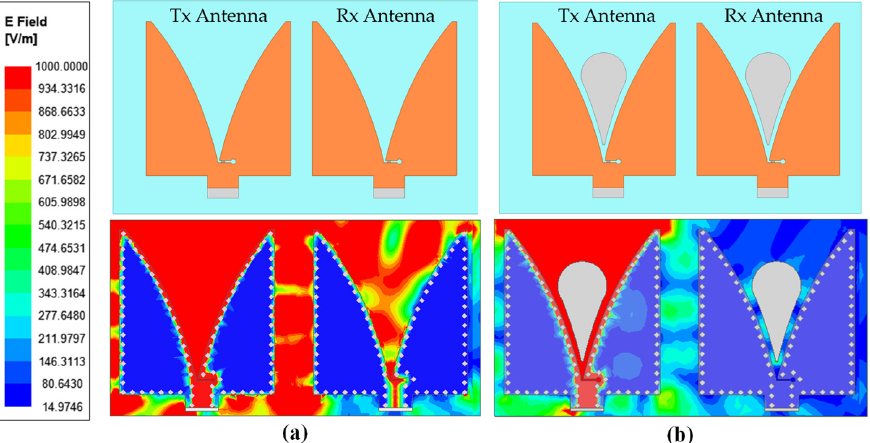
Figure 9. The simulated E-field distributions at 2.45 GHz of the antenna: ( a ) Without the teardrop- shaped structure; ( b ) with the teardrop-shaped structure.